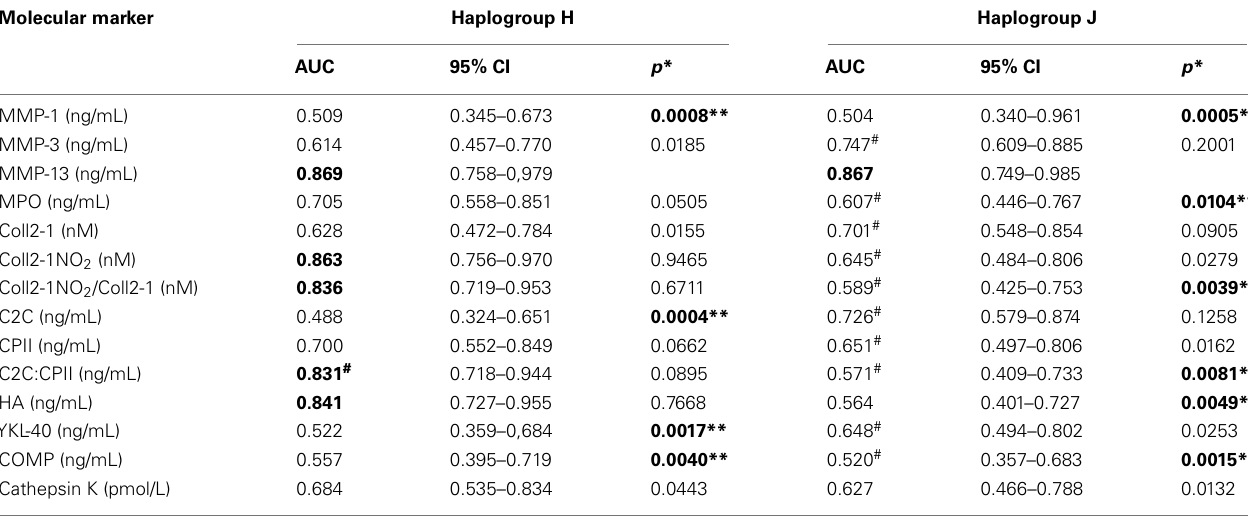
Table 2 | Comparative analysis of the receiver operating characteristic (ROC) curves of biomarkers for haplogroups H and J. Molecular marker